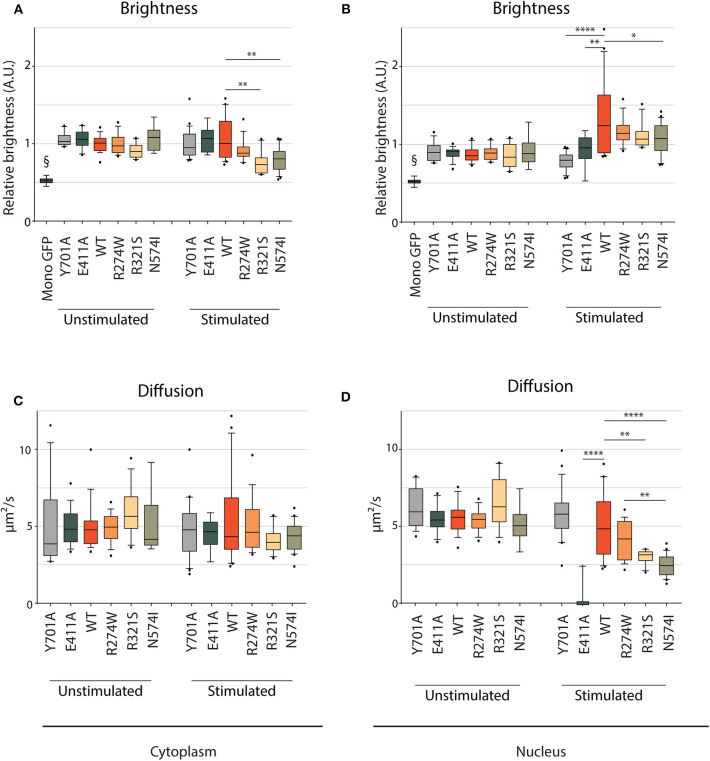
RICS analysis of STAT1-GFP WT and GOF mutations in U3A cells. Brightness (A,B) and average diffusion constant as a marker of mobility (C,D) measurement of cytoplasmic and nuclear STAT1-GFP fusions in unstimulated U3A cells and cells stimulated with IFNγ (1 U/μl). §GFP monomers, measured in HEK cells. Brightness is expressed in arbitrary units and plotted as fold increase compared to cytoplasmic WT. Data in panels (A–D) (n > 7) are represented in box and whiskers plots. The central line represents the median, while the box extends from the 25th to 75th percentiles with whiskers spanning 10–90% intervals. Dots outside these intervals are represented as single dots. Statistical analysis: One-way ANOVA with Tukey's post-hoc test. *P < 0.05; **P < 0.01; ****P < 0.0001.